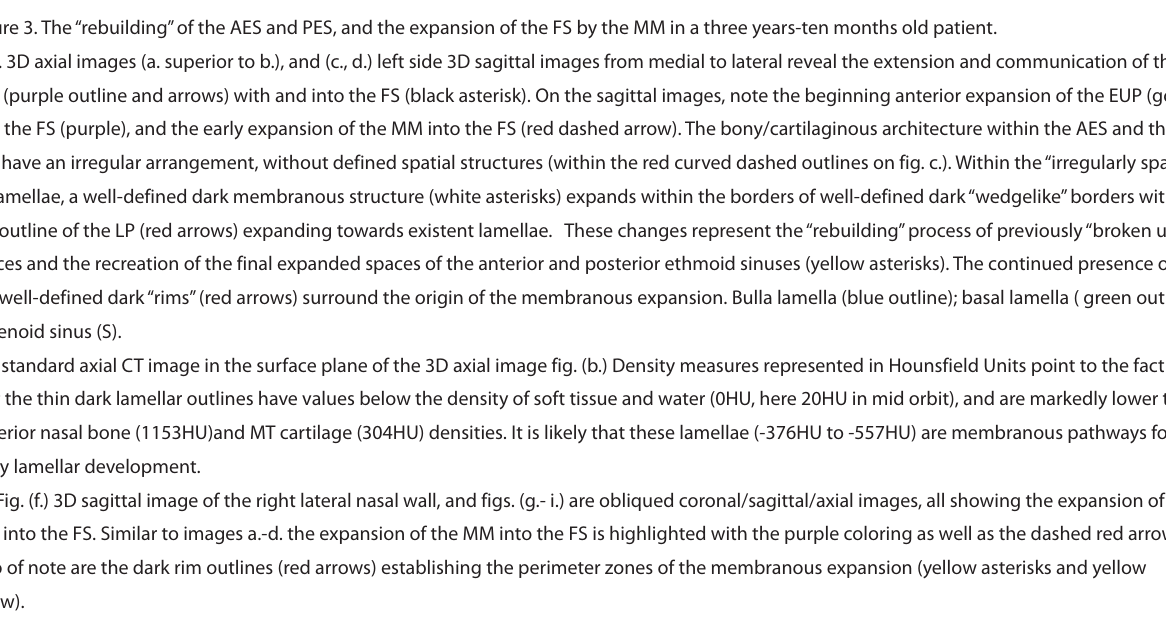
f.-i. Fig. (f.) 3D sagittal image of the right lateral nasal wall, and figs. (g.- i.) are obliqued coronal/sagittal/axial images, all showing the expansion of the MM into the FS. Similar to images a.-d. the expansion of the MM into the FS is highlighted with the purple coloring as well as the dashed red arrows. Also of note are the dark rim outlines (red arrows) establishing the perimeter zones of the membranous expansion (yellow asterisks and yellow